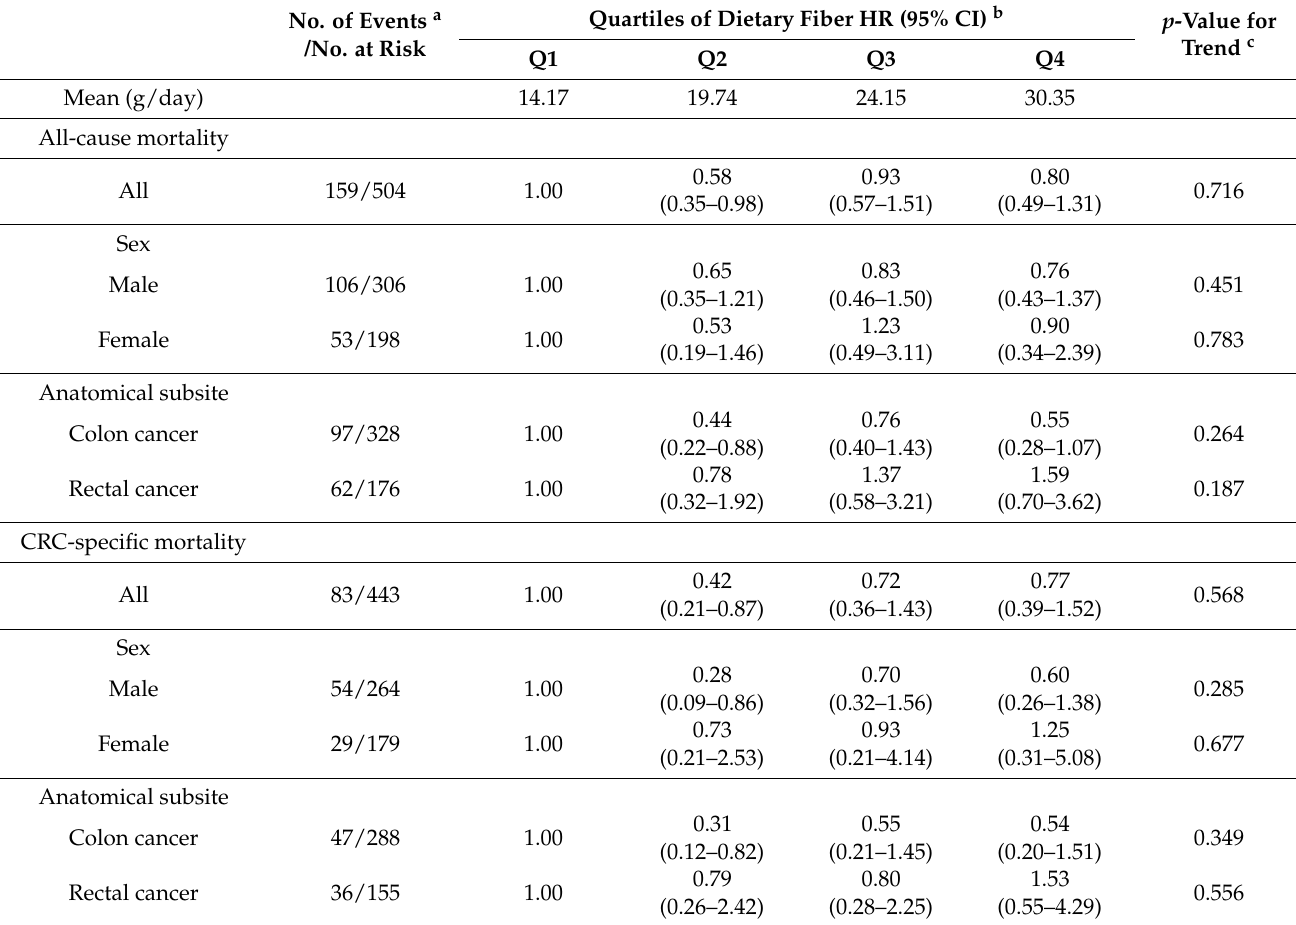
Table 2. Associations of dietary fiber intake with all-cause mortality and CRC-specific mortality among CRC